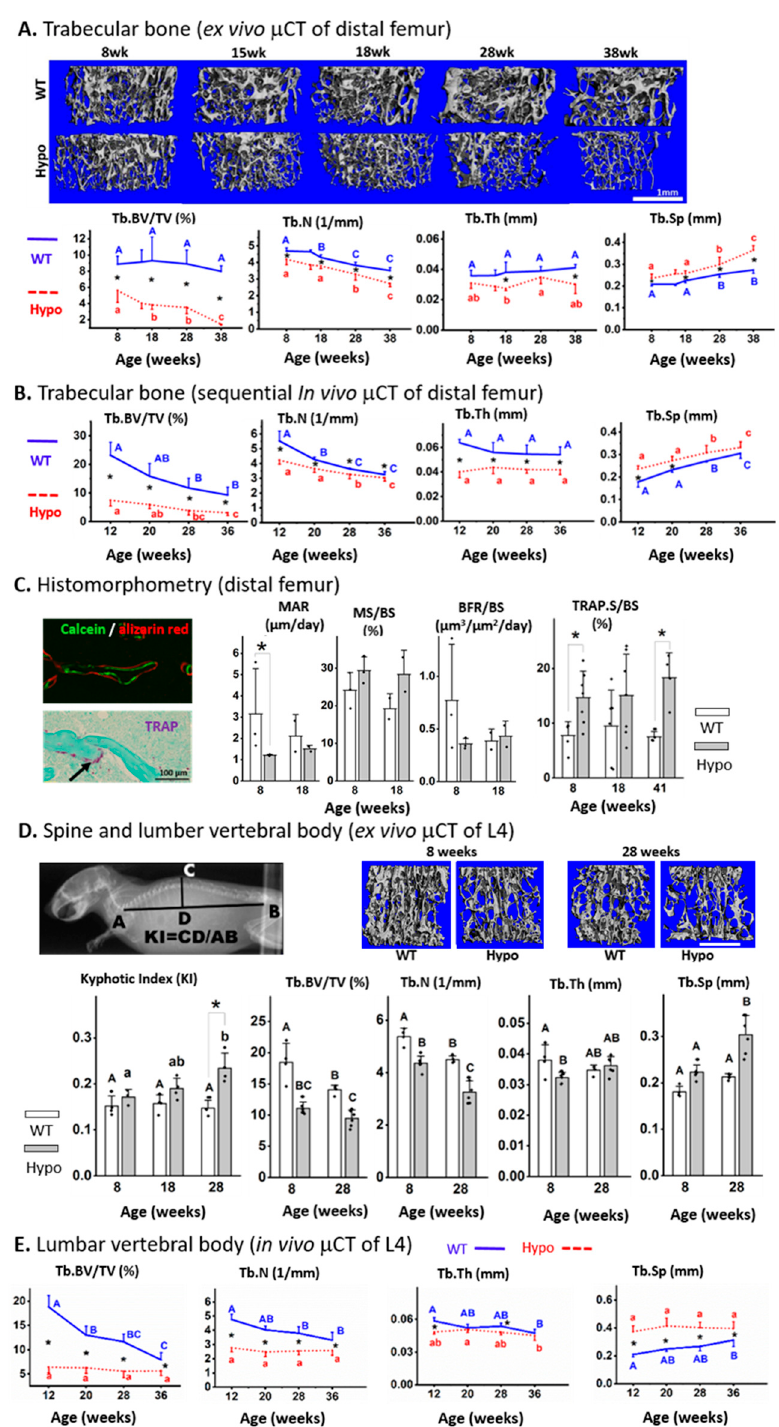
Figure 1. Severe trabecular osteoporosis in perlecan-deficient (Hypo) male skeletons. Distal femur (long bone) was examined ( A ) in various age groups by ex vivo µ CT imaging and ( B ) in a longitudinal study using in vivo µ CT imaging. ( C ) Histomorphometric and histological analysis of osteoblastic bone formation indices and osteoclastic TRAP staining. The axial skeleton (spinal column and / or the vertebral body L4) was examined ( D ) in various age groups by ex vivo µ CT imaging ( E ) and in a longitudinal study by in vivo µ CT imaging. Significance for within-genotype age comparisons is indicated by di ff erent letters (uppercase for WT and lowercase for Hypo) and between-genotype comparisons are indicated by * p < 0.05). Scale bar in Figure 1D = 1 mm.